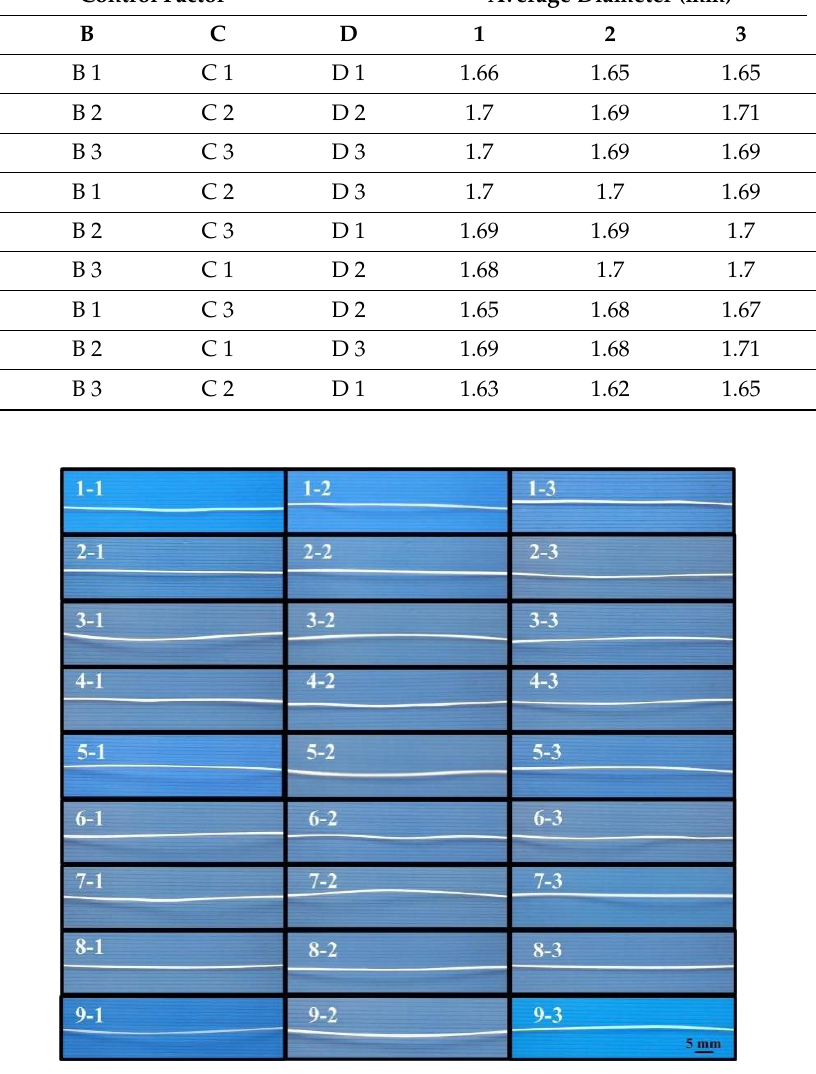
Figure 8. Results of PLA filament fabricated by different process parameters. Table 3. Response table of S/N ratio based on the-larger-the-better quality characteristics.